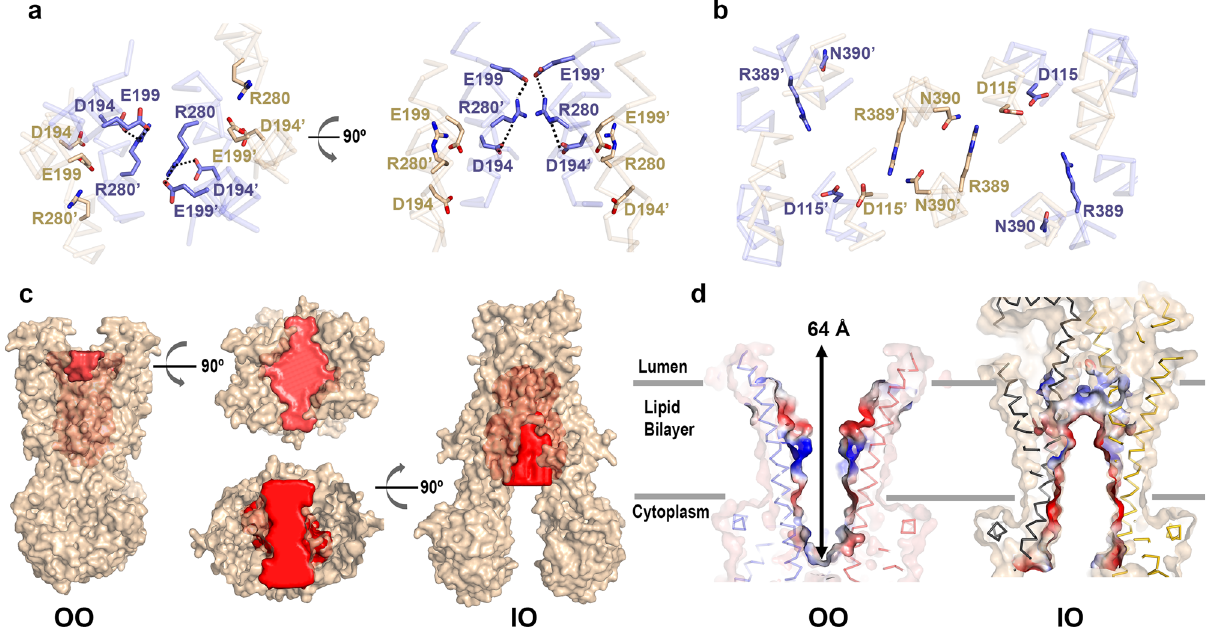
Fig. 3 Comparison of IO and OO TMD cavities of ABCD1. a All C α -atom overlay of IO and OO ABCD1 structures (gold and blue sticks, respectively) but showing intracellular gate and surrounding residues viewed from the peroxisome lumen (left) and membrane plane (right). Equivalent residues from the two halves are distinguished by a prime symbol ( b ) same as ( a ) showing residues comprising the peroxisomal gate. c Surface representation of OO and IO structures of ABCD1 with solvent-exposed cavities colored red. d Slice through electrostatic surfaces of OO and IO structures of ABCD1 focused on the TMD region.